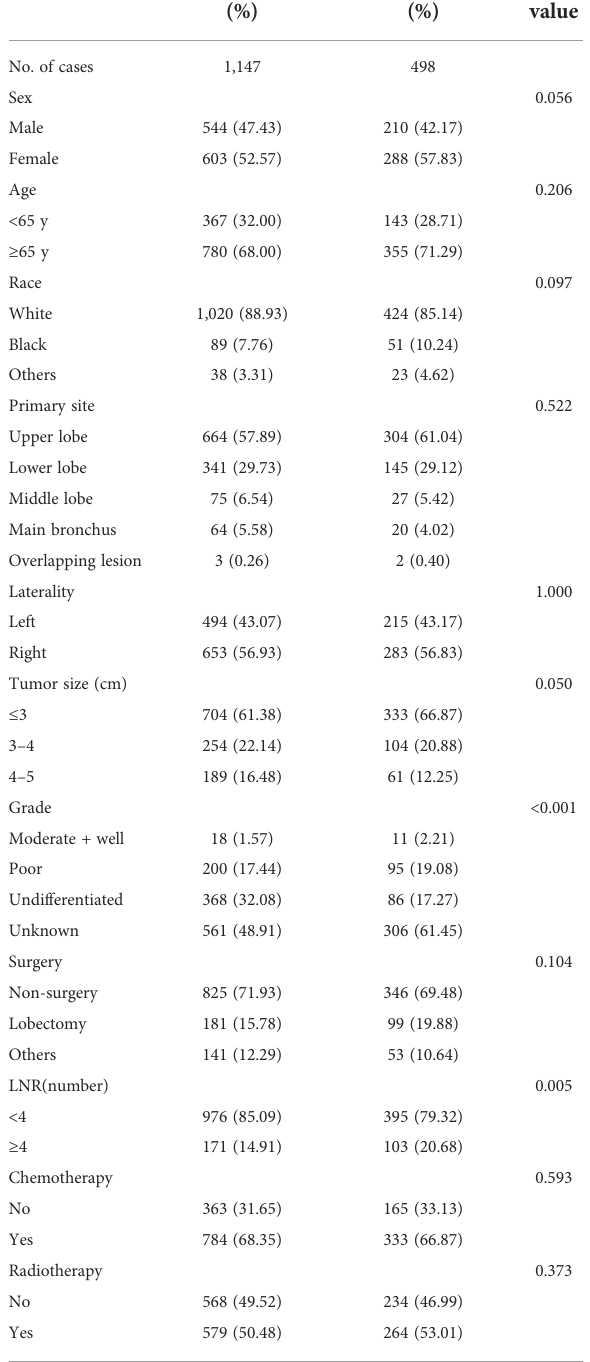
TABLE 1 Demographic and clinicopathologic characteristics of the training and validation cohort. Characteristics Training